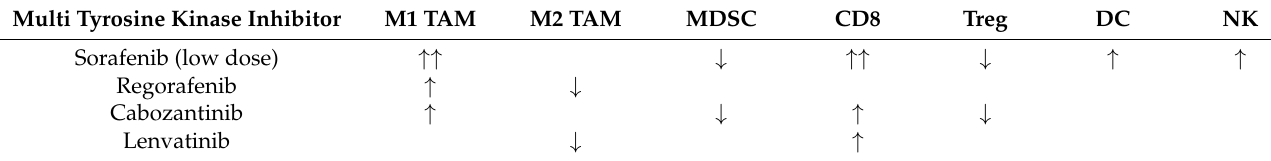
Table 1. Immunological effects of multi tyrosine kinase inhibitors in hepatocellular carcinoma [13]. TAM: tumor associated macrophages, MDSC: myeloid derived suppressor cells, Treg: CD4 T regulatory cell, DC: dendritic cell, NK: natural killer cell. Multi Tyrosine Kinase